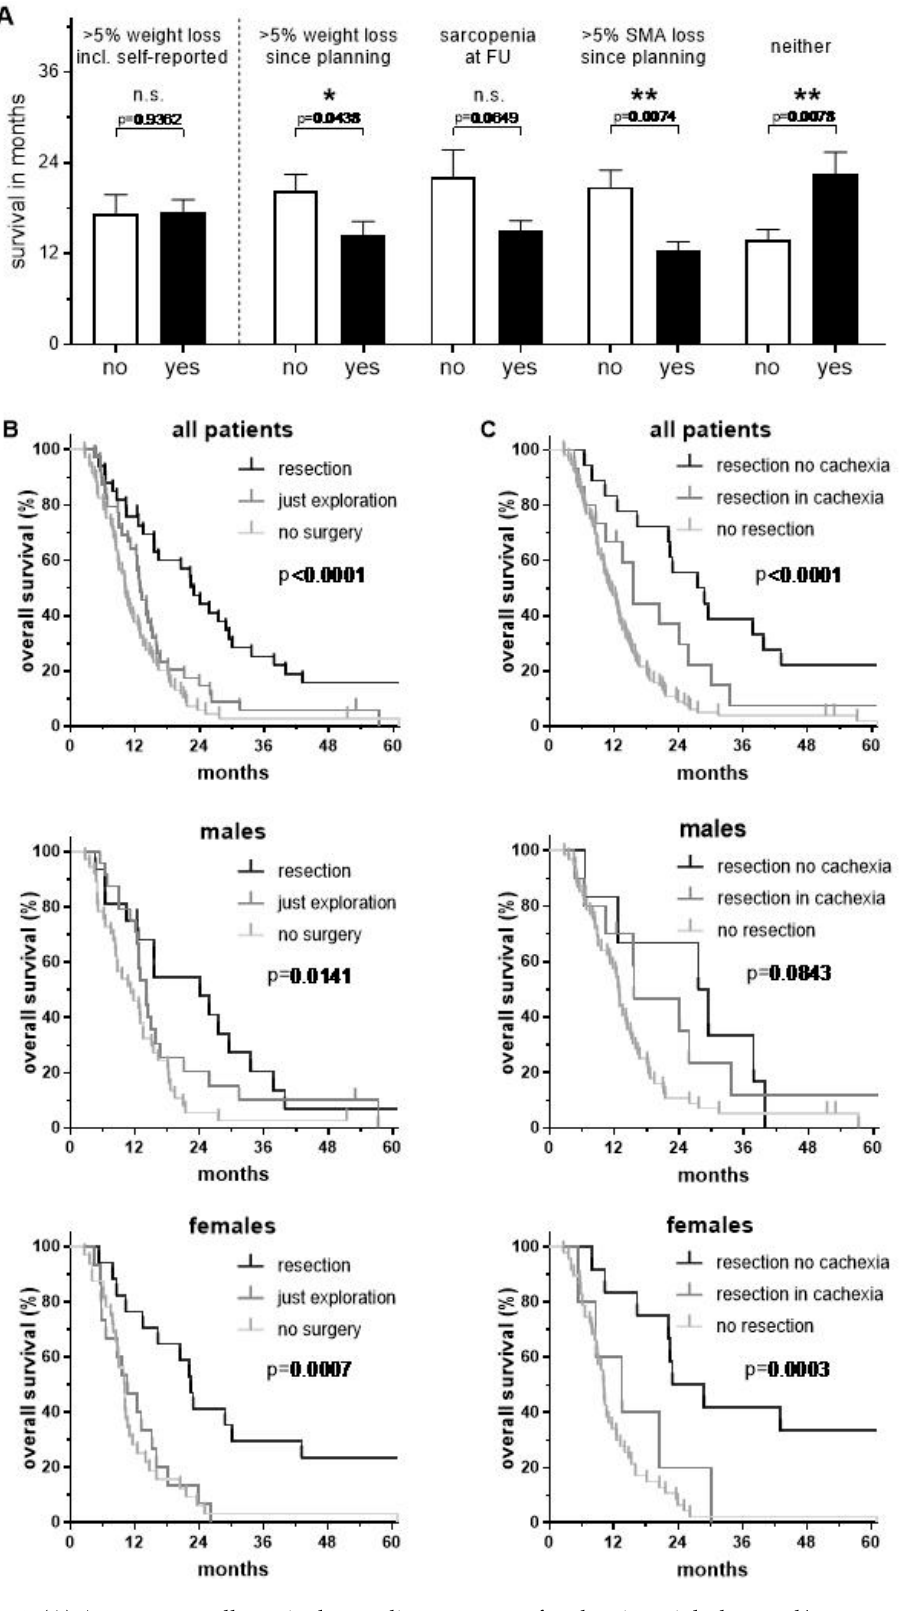
Figure 4. ( A ) Average overall survival according to status of cachectic weight loss and/or sarcopenia. ( B ) Kaplan–Meier survival curves grouped according to the extent of surgical resection and ( C ) in combination with or without cachexia as well as by gender.